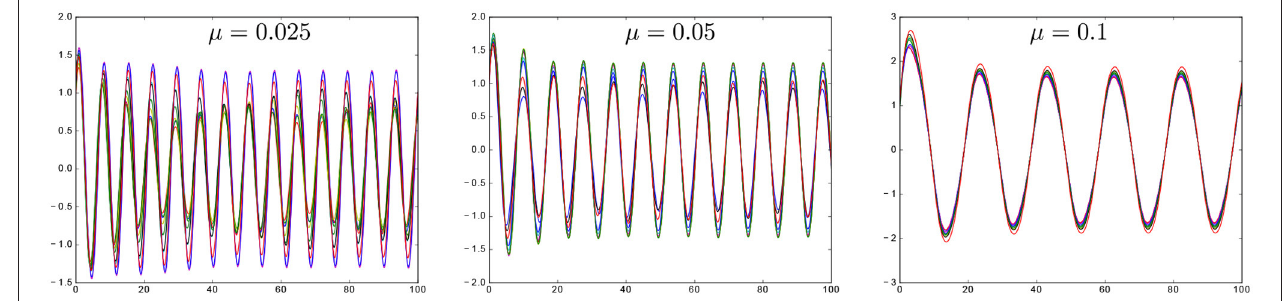
FIGURE 4 | Synchronization and modulation of the synchronization frequency via coupling strength in model (9), for N in the interval [0.95,1.05], all-to-all coupling and varying µ